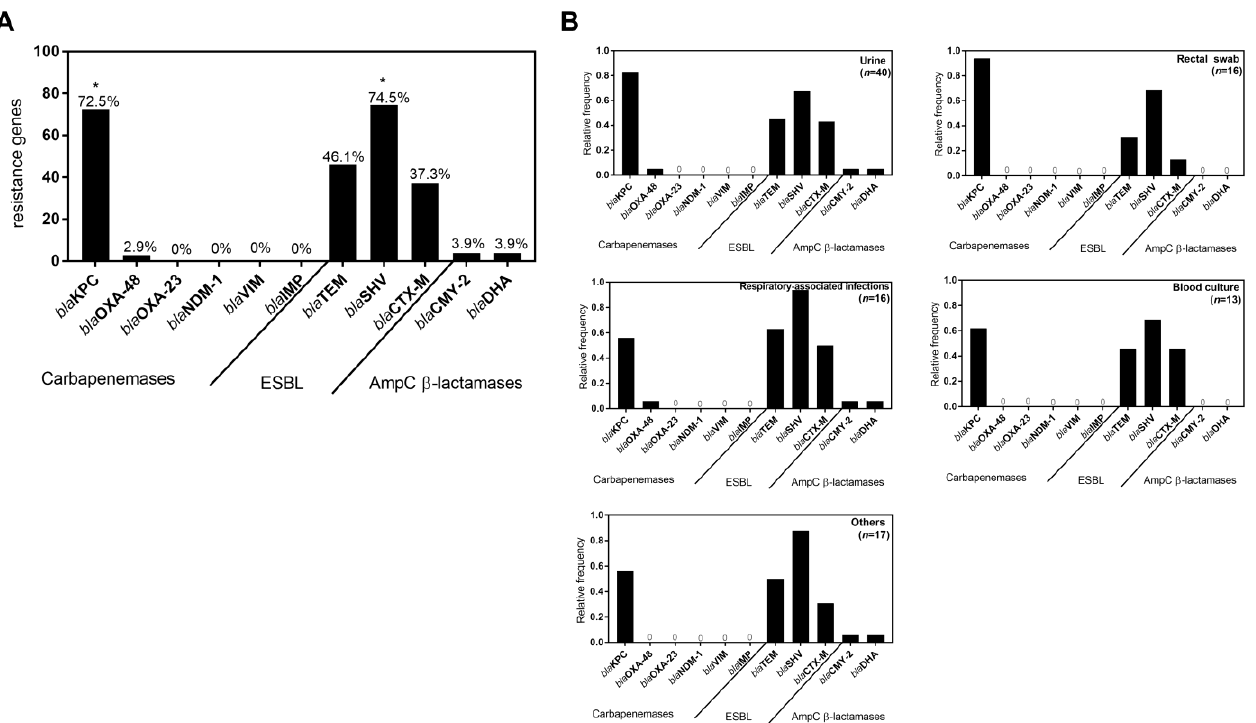
Figure 4. ( A ) Prevalence of acquired β -lactam resistance genes in MDR K. pneumoniae isolates from two Portuguese hospitals. * Prevalence of a specific resistance gene was statistically different when compared with the other genes from the same group (one-way ANOVA; p < 0.05). ( B ) Relative frequency of acquired β -lactam resistance genes by sample source. The isolates were categorized into five major sample sources: urine, rectal swab, respiratory-associated infections (including sputum, bronchial aspirate, and bronchoalveolar lavage isolates), blood culture, and others (including remaining sample sources).